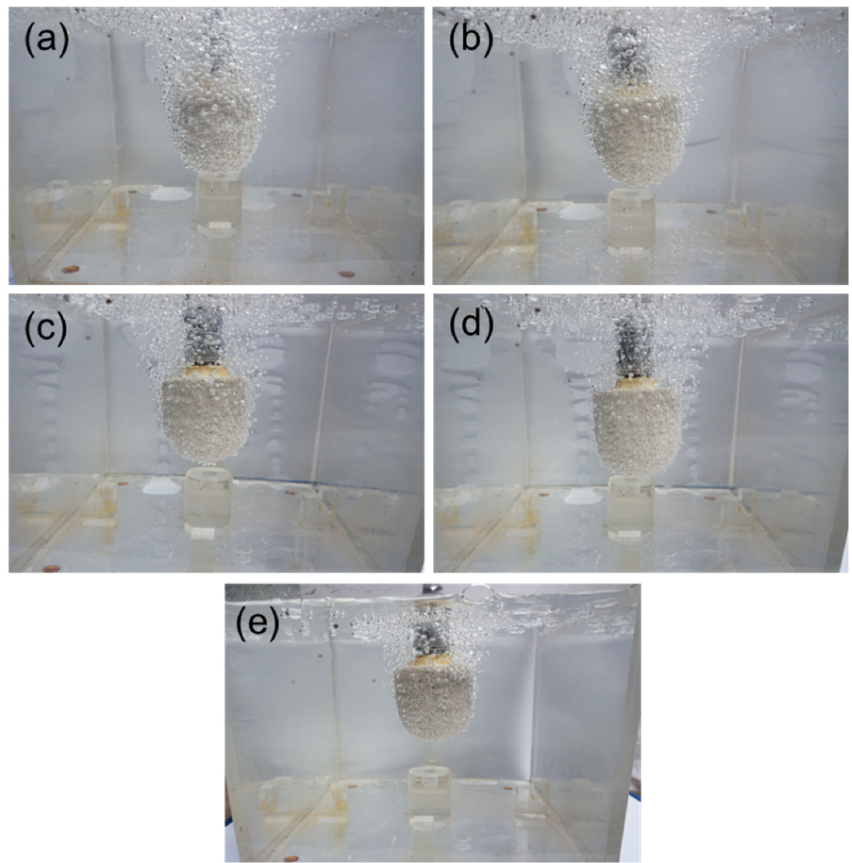
Figure 5. The hydraulic simulation photo of the porous nozzle with different proportions of fine sand: ( a ) 0, ( b ) 25 wt.%, ( c ) 50 wt.%, ( d ) 75 wt.%, ( e ) 100 wt.%.